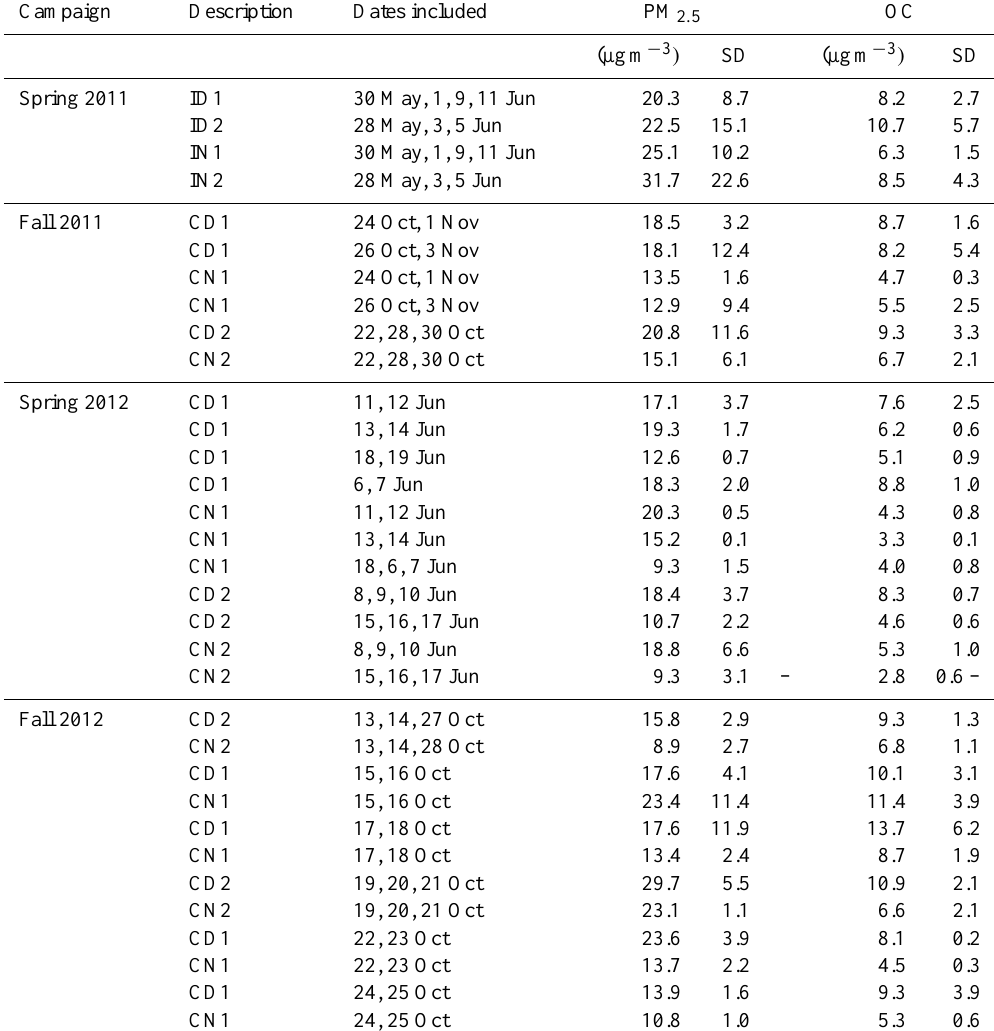
Table 2. Characteristics of individual and composite samples for each monitoring campaign. Values for PM 2 . 5 are the averages obtained from the SIMA network. OC concentration values are the average values reported by Mancilla et al. (2015). SD represents standard deviation, I indicates that the dates included were analyzed individually, C indicates that the dates included were pooled to form a composite, D represents daytime sampling, N represents nighttime sampling, 1 refers to weekday sampling, and 2 refers to weekend